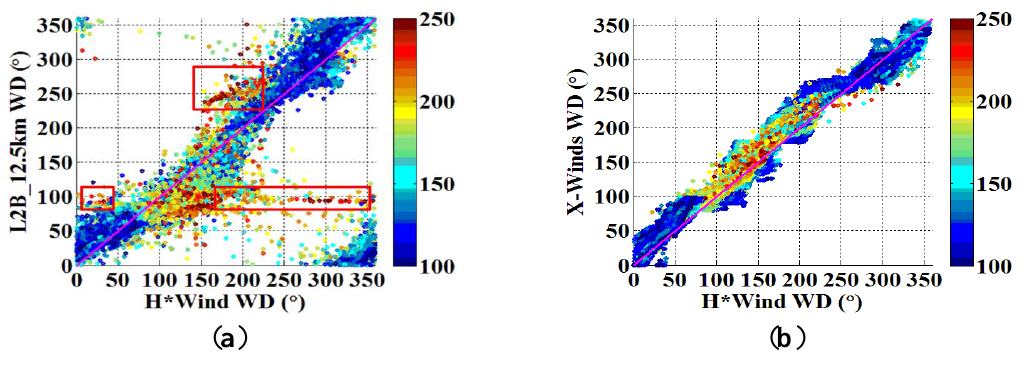
Figure 9. Composite wind direction comparisons for ten hurricane cases: ( a ) L2B-12.5 km wind directions comparison with H*Wind, and ( b ) X-Winds’ wind directions comparison with H*Wind. Color scale denotes the QRad TbH (warm colors indicate